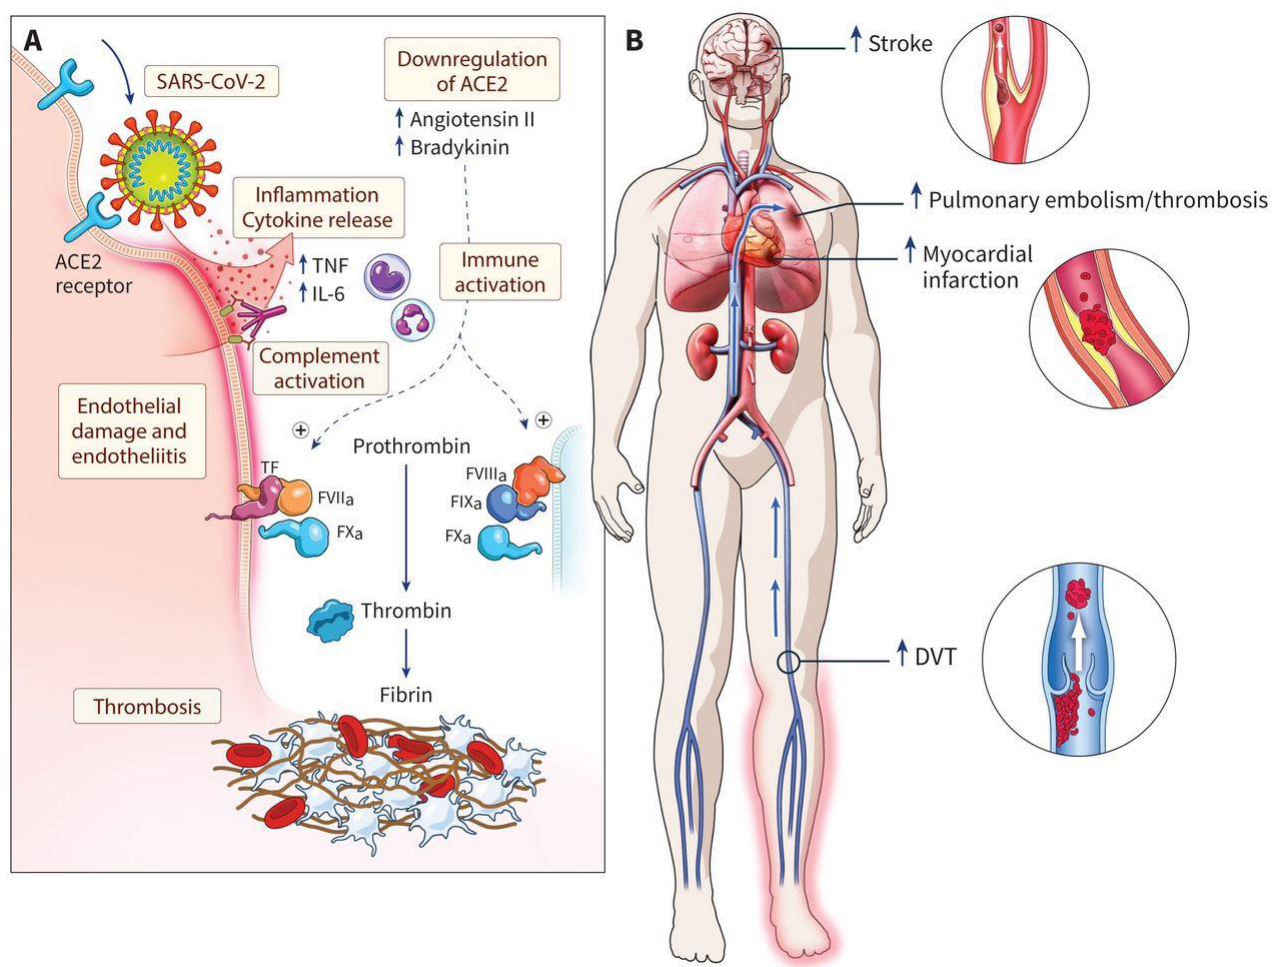
Figure 3. Possible mechanisms for thrombosis in coronavirus disease 2019 (COVID-19) and clinical consequences. ( A ) Injury to the endothelium initiated by severe acute respiratory syndrome coronavirus 2 (SARS-CoV-2) entry into cells via the angiotensin-converting enzyme 2 (ACE2) receptor is thought to lead to diffuse endotheliitis. The endothelial damage may result in an inflammatory host response characterized by excessive immune activation and cytokine storm, which promotes hypercoagulability and thrombosis. ( B ) Possible venous and arterial thrombotic complications associated with COVID-19. Original illustration by freelance medical illustrator Gail Rudakevich. Reprinted with permission from Ref. [15]. Copyright ©2021, Canadian Medical Association. Abbreviations: DVT, deep vein thrombosis; FVIIa, factor VIIA; IL-6, interleukin 6; PE, pulmonary embolism; TF, tissue factor; TNF, tumor necrosis factor α.